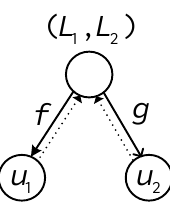
Figure 2. Basic unit model of a polar code.